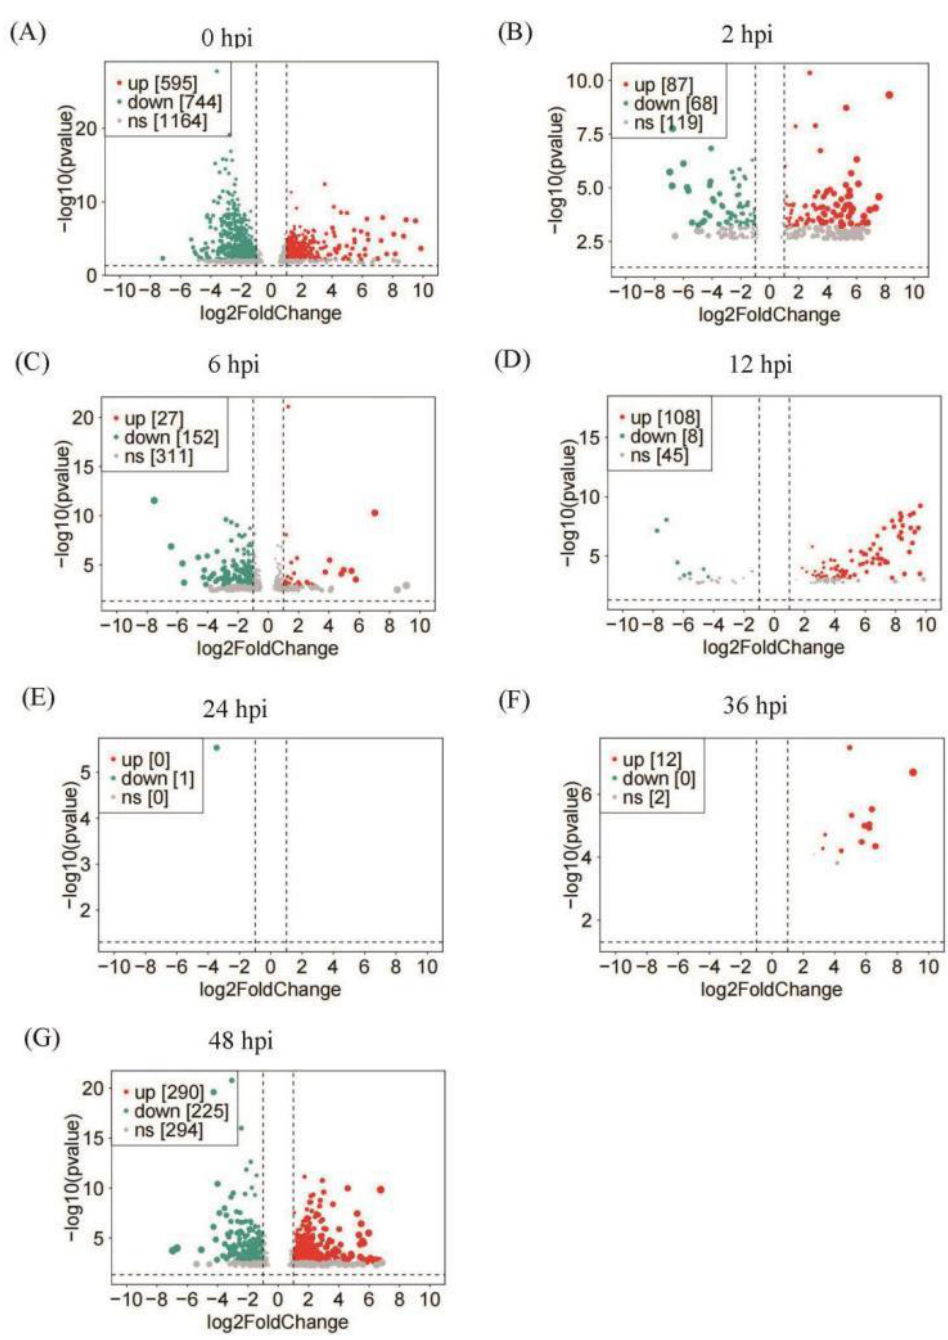
Figure 2. General analyses of host larval expressed-genes responding to EcobNPV-QV vs. EcobNPV-QF4 infection. Genes with |log 2 foldchange| >= 1 and padj (corrected p -value) <= 0.05 were recognized as the differentially expressed genes (DEGs). Figures ( A – G ) represent the volcano plots of DEGs at 0–48 hpi. Red plots are the genes with significant up-regulated differential expression (up), green plots are those with significant down-regulated differential expression (down), and gray plots are the genes with no significant difference in expression (ns).